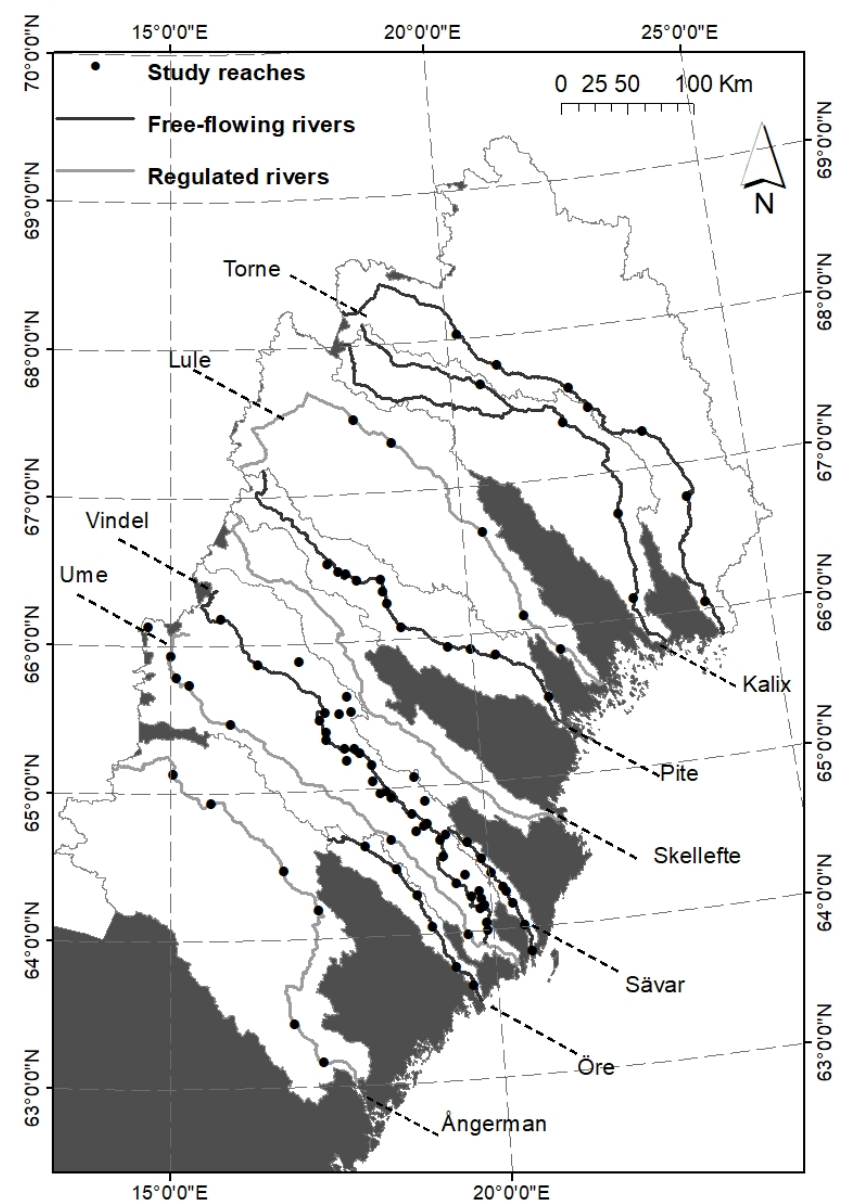
Figure 1. Selected reaches along the 10 river basins in northern Sweden. Black lines are free-flowing rivers, and grey lines are regulated rivers. Dots represent the 94 study reaches, and lines represent the course of the main channels of the rivers.